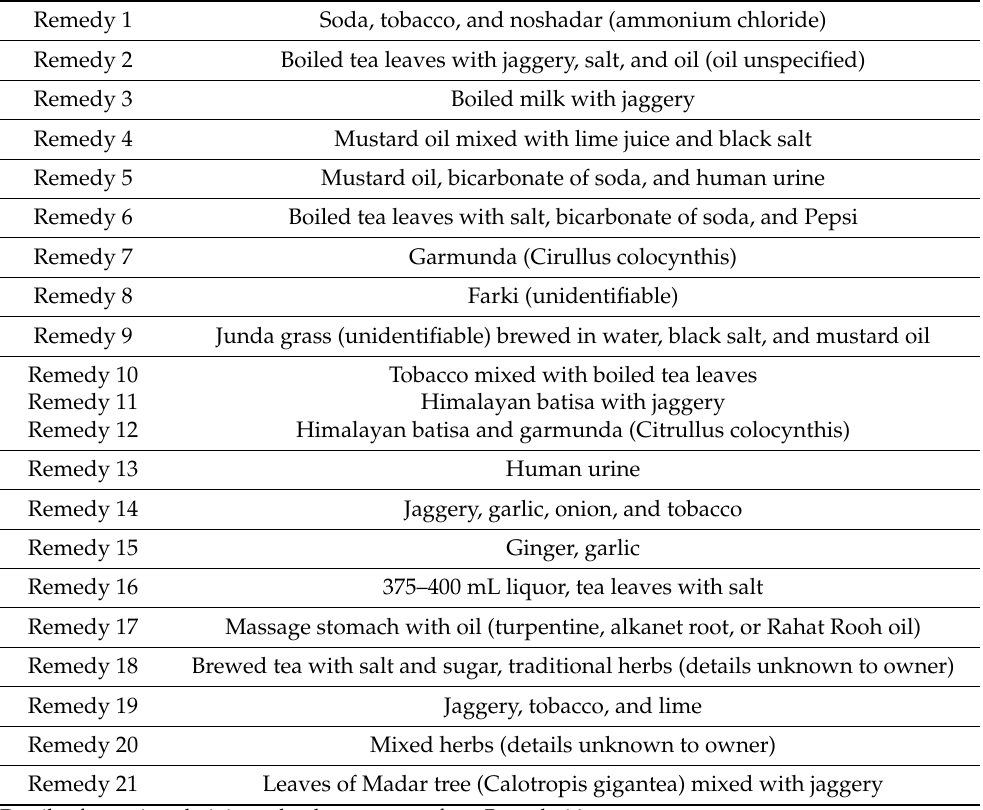
Table 1. Examples of self-treatment measures for